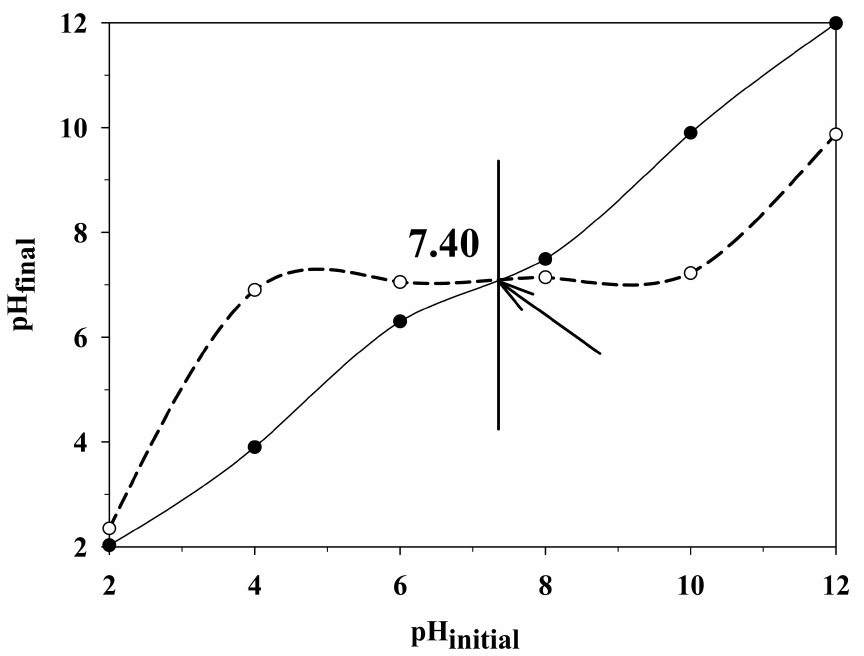
Figure 7. pH point of zero charge (pH pzc ) determination plot of Ag-ZnSnO 3 photocatalyst (broken line: final pH points, and solid line: initial pH